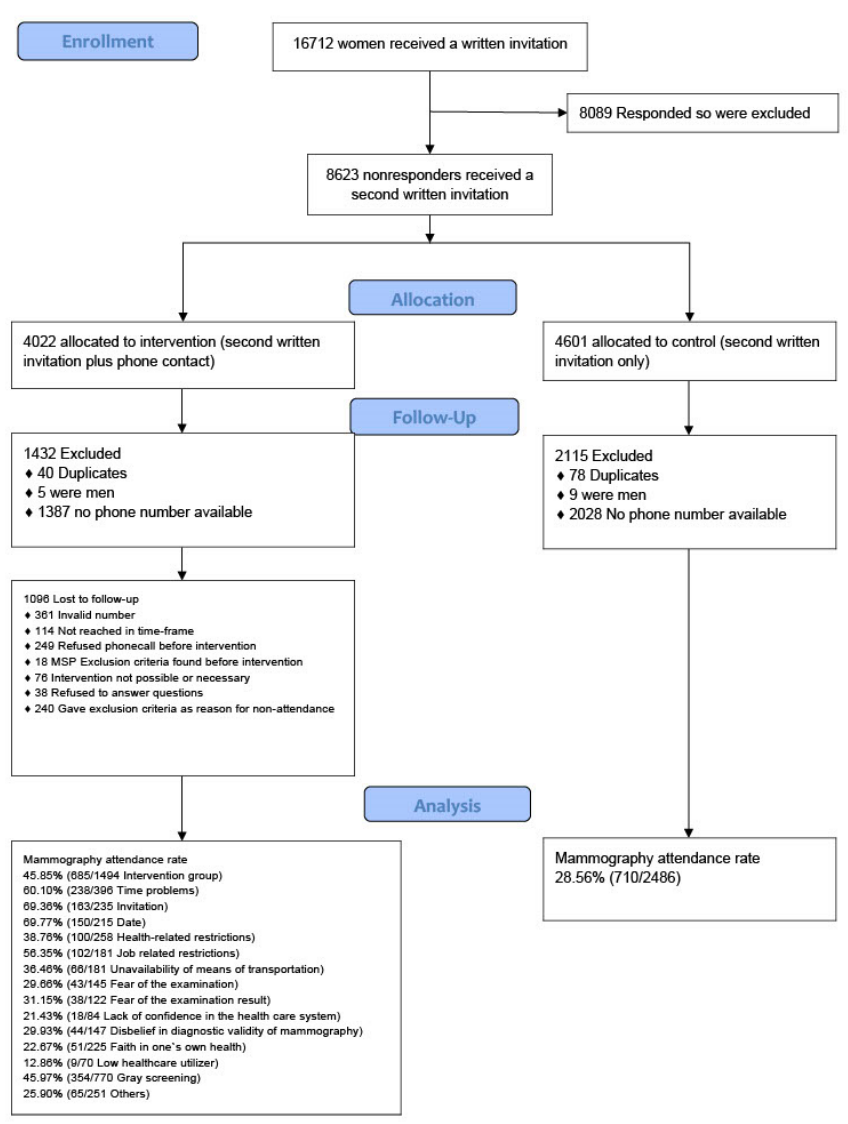
Figure 1. Participant flow chart.